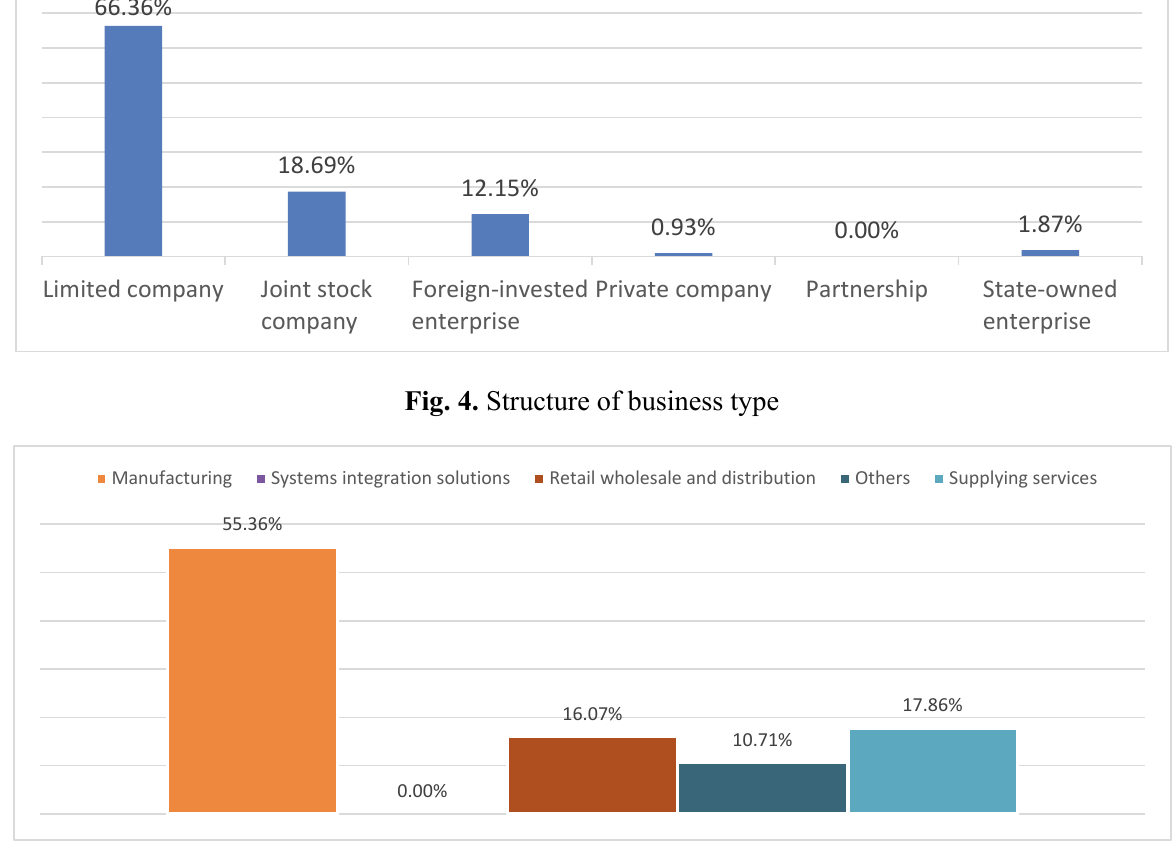
Fig. 5. Key operational structure of the